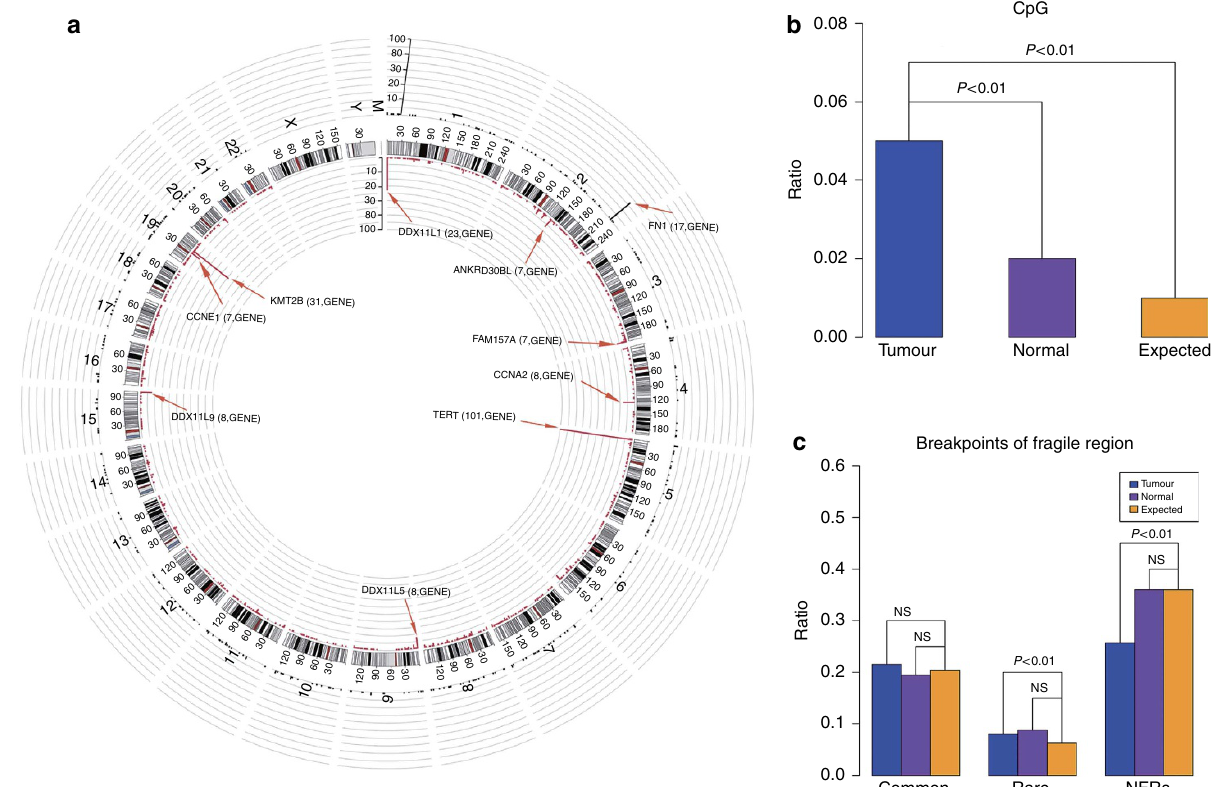
Figure 1 | Distribution of HBV integration breakpoints throughout the human genomes in 426 paired samples. ( a ) Distribution of integration breakpoints across the human genome in 426 paired samples. Each bar represents the sample frequency of HBV integration breakpoints at a particular locus in the human genome (hg19). Tumour (red) and non-tumour (dark blue) samples with HBV integrations are shown on the inner and outer circles, respectively. Histogram axis units represent number of samples. Some loci with a high frequency of integration are marked. GENE. ( b ) Comparison of the breakpoints in the CpG island region of 426 paired samples. The expected (assuming uniform, random distribution, yellow) and the observed (actual numbers, tumour: blue; normal liver tissue: purple) percentages of HBV integration breakpoints of tumour and non-tumour samples in CpG islands region are shown. P values were calculated by w 2 test. ( c ) Distribution of integration breakpoints in the fragile region (FR) of 426 paired tumor and non-tumor tissues. The expected (assuming uniform, random distribution, yellow) and the observed (actual numbers, tumour: blue; normal liver tissue: purple) ratios of HBV integration breakpoints in common fragile region, rare fragile region and non-fragile region are shown. P values were calculated by w 2 test. Common: common FR; rare: rare FR; NFRs: non-fragile regions.